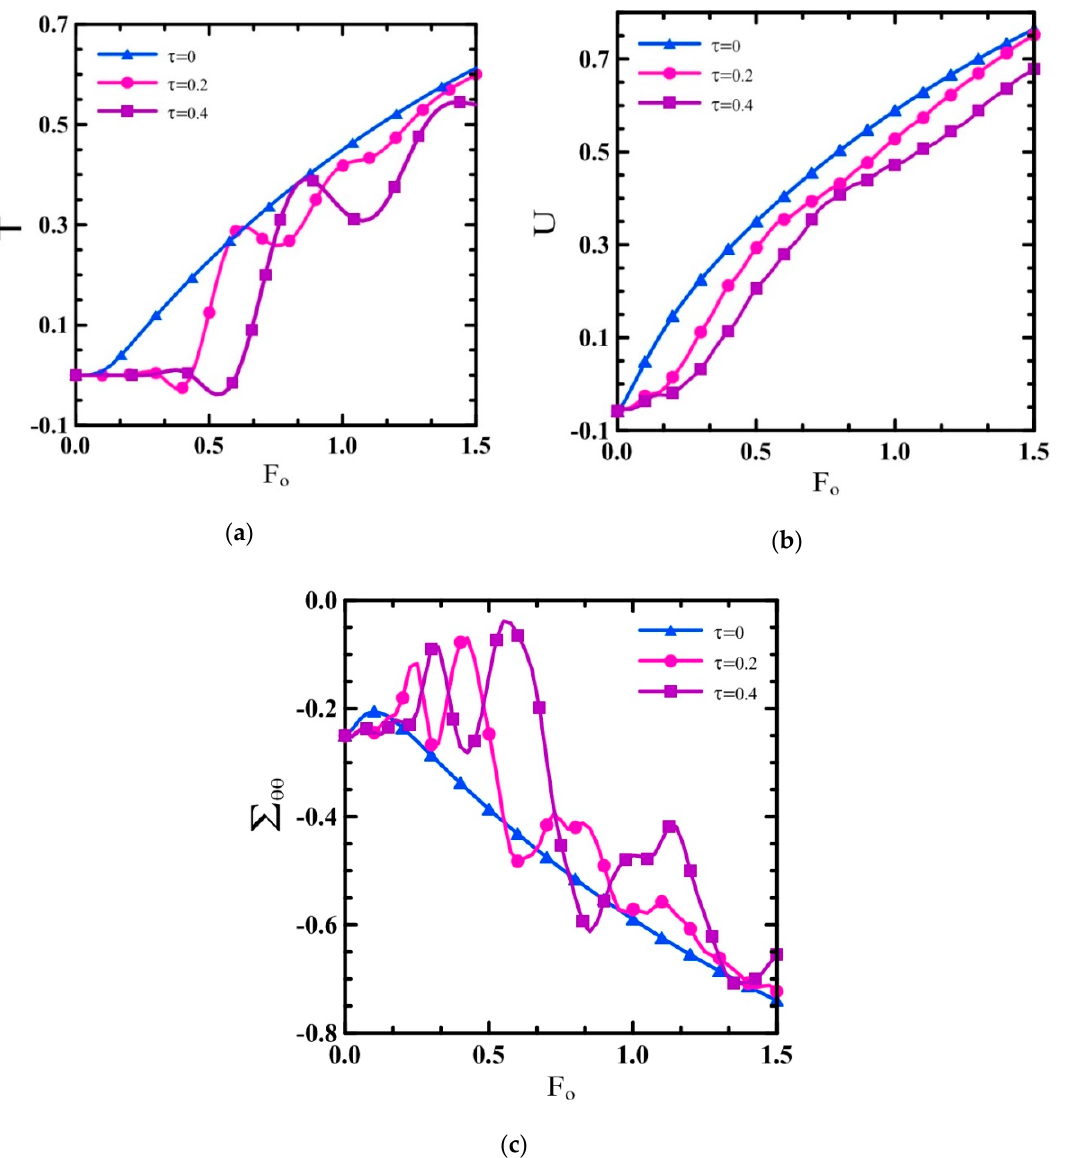
Figure 8. ( a – c ): Time histories of the thermoelastic field variables against the relaxation time ( ) (cid:16) (cid:17) 1, n = 1, h c / h p = 5, θ 0 = 75 ◦ , ψ = 0.03, ξ = 0.5, θ = 0.5 θ 0 0 0